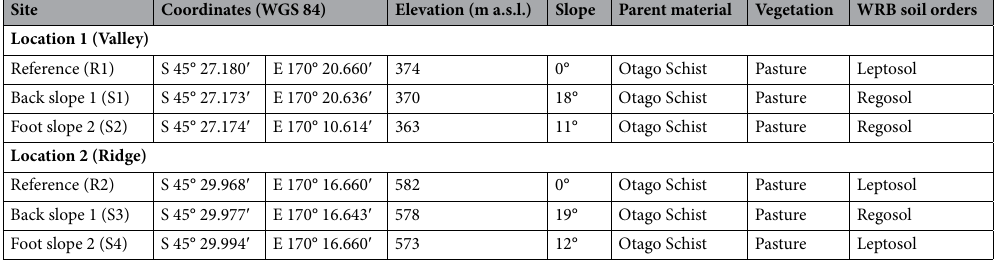
Table 1. Study site